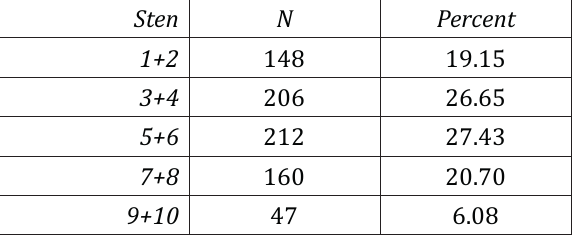
Table 3. The results of Rosenberg Self Esteem